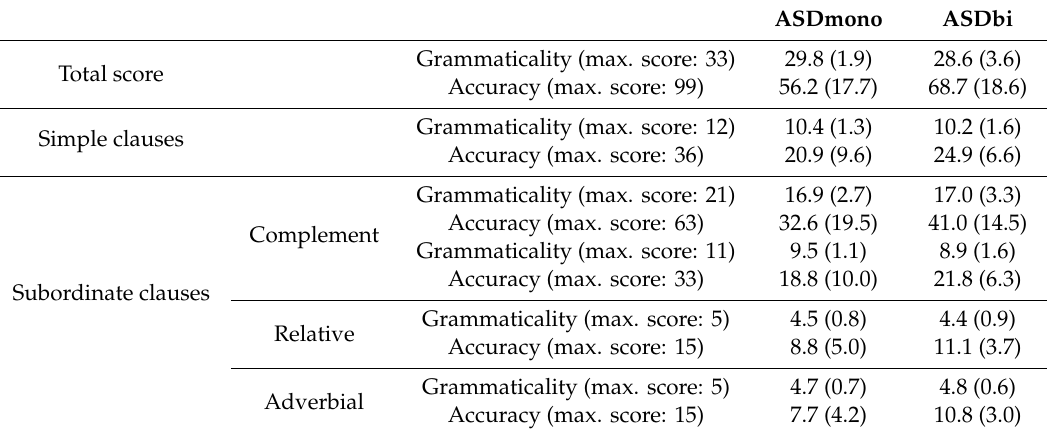
Table 3. Sentence repetition performance means (and SD) in monolingual and bilingual children with autism spectrum disorder